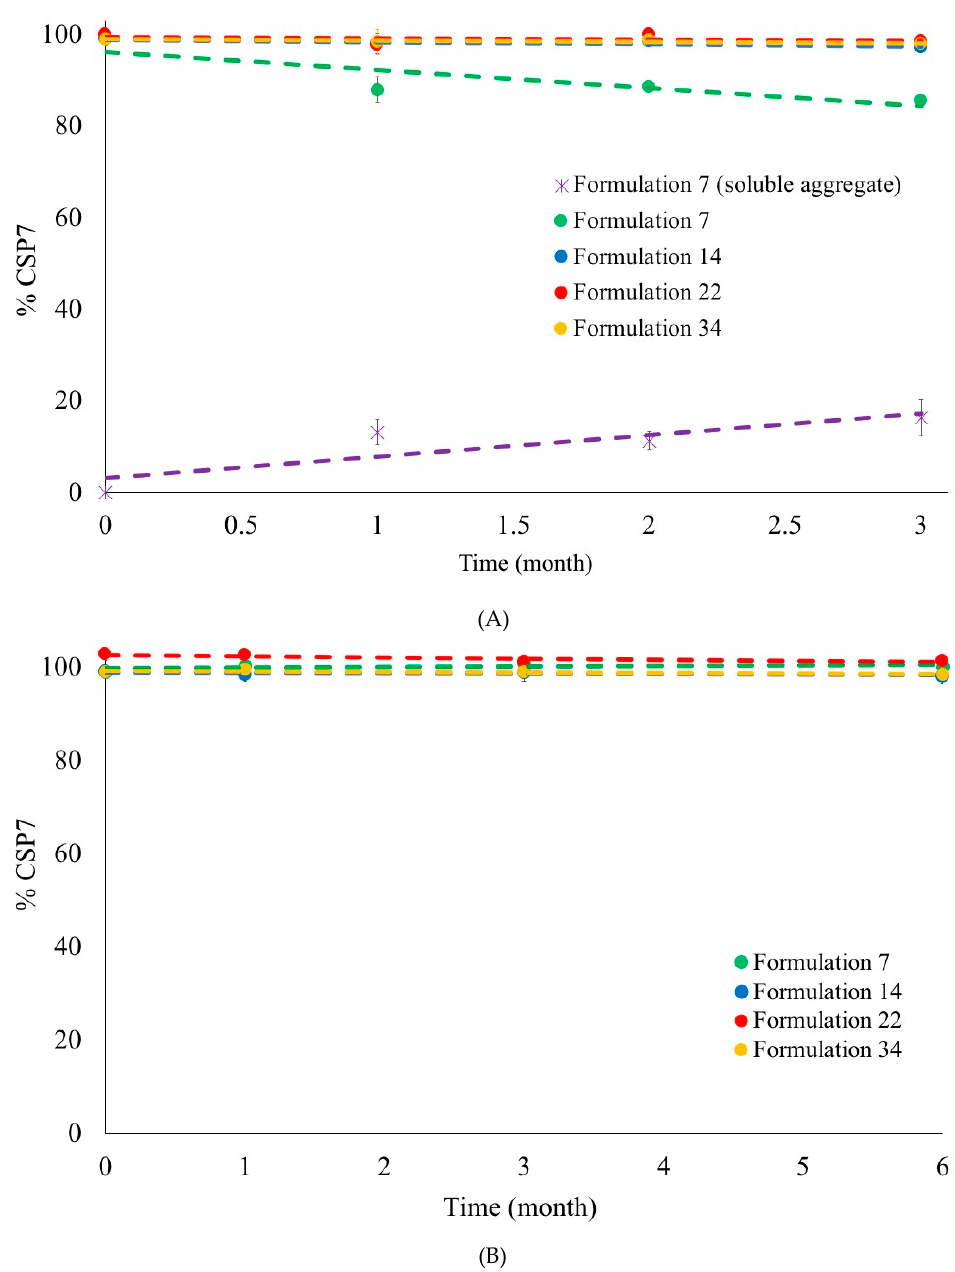
Figure 12. Recovery of CSP7 in lyophilized state after storage: ( A ) 25 ° C/60% RH; ( B ) 5 °C. Table 5. pH of solution after reconstitution of lyophilized formulations.